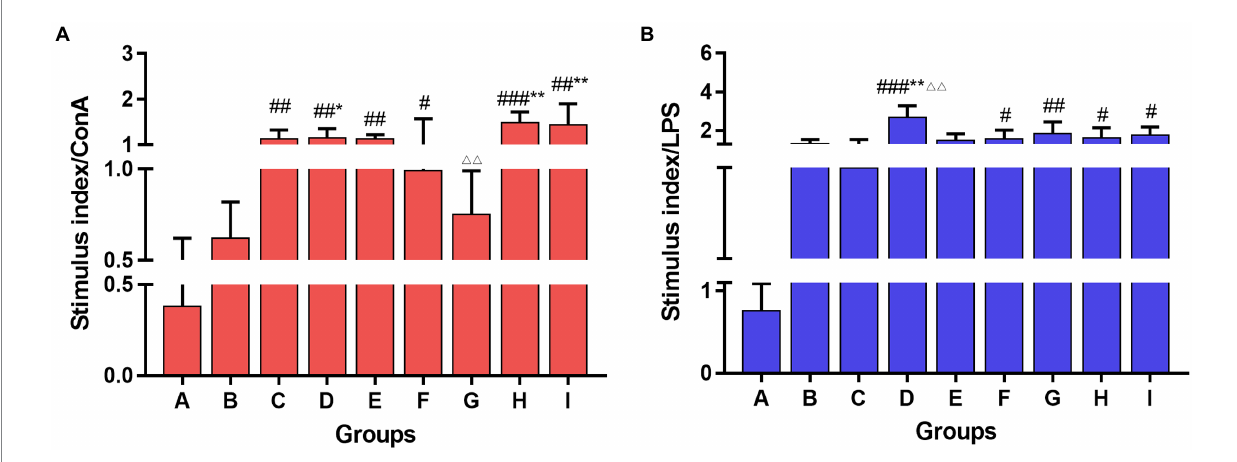
FIGURE 5 Lymphocyte proliferation of the spleen stimulated with Con A (A) and LPS (B) among groups. One-way ANOVA followed by Tukey’s multiple comparison test was conducted to compare two groups. Significant differences were defined between the PBS group and the vaccination groups